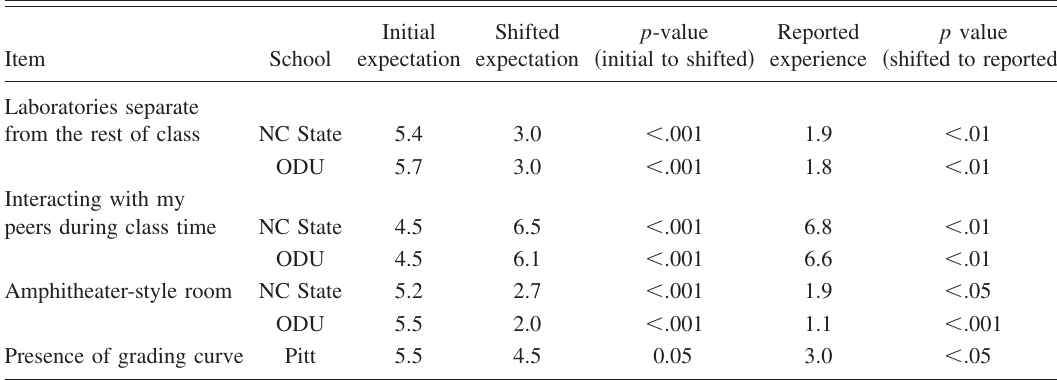
TABLE II. Sample items fitting an “undershooting” profile.